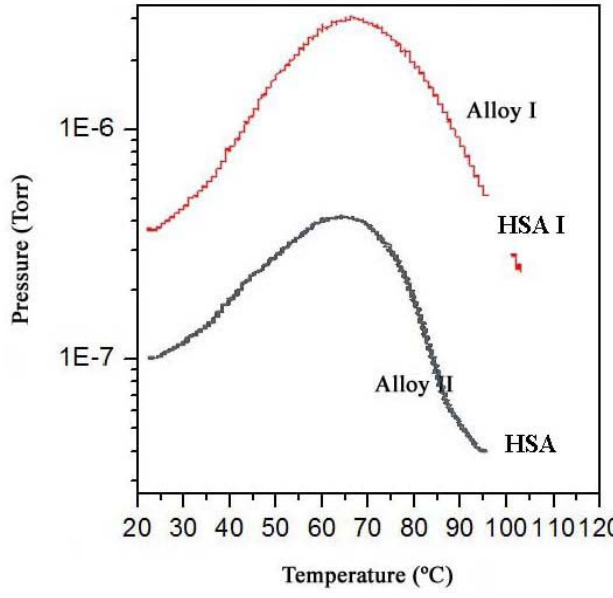
Figure 5. MB-TDS spectrum of two (previously electrochemical) charged hydrogenated MlNi Co Al Mn alloys submitted to a heating rate of 1 °C/min. The HSA (I) has a 3.6 0.85 0.3 0.3 larger absorbed hydrogen mass than HSA (II). Adapted from [6].